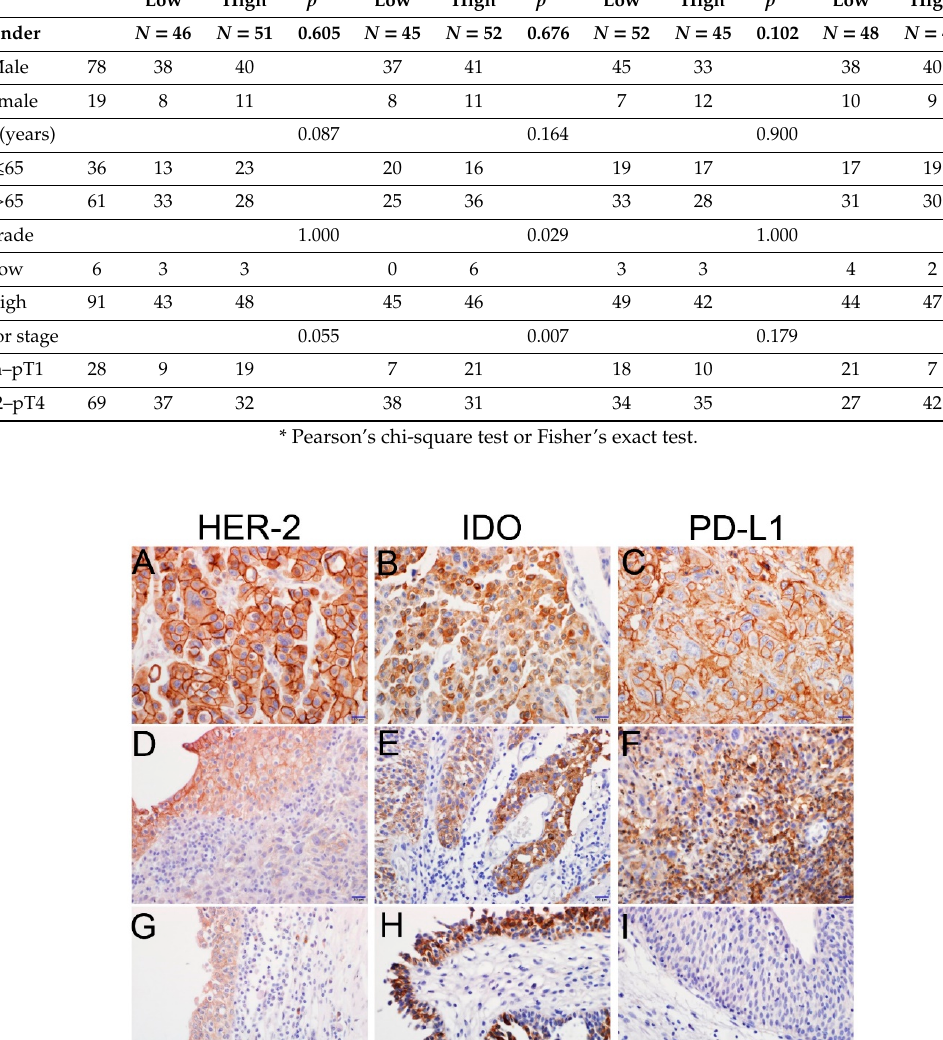
Table 1. Correlations of HER2, IDO, and PD-L1 expressions with clinicopathological factors in 97 patients with urothelial carcinoma of the bladder. Variable No.